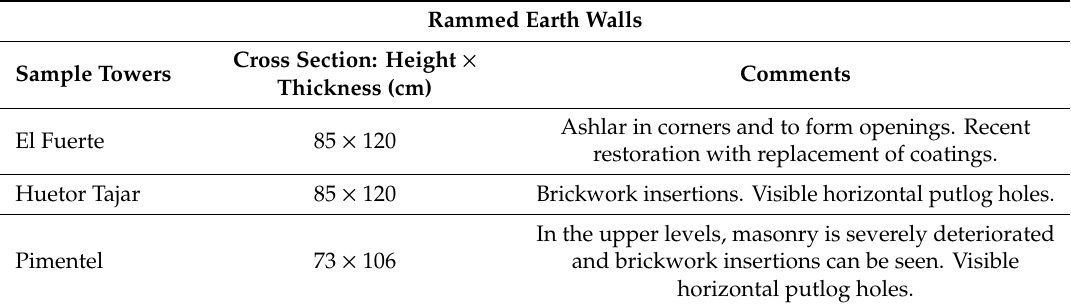
Table 2. Data from Towers Built Using the Rammed Earth Technique.